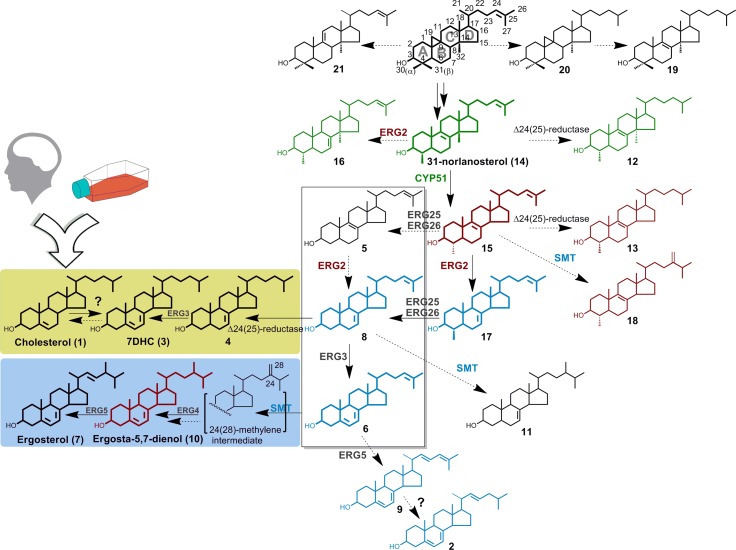
Sterol metabolic network in N. fowleri.The pathway is reconstituted based on the metabolites observed in the untreated N. fowleri (shown in bold) and treated with the CYP51 (shown in green), SMT (in blue) and ERG2 (in dark red) inhibitors. Metabolites not observed in the wild-type N. fowleri are depicted in thin lines. The cholesterol arm of the pathway is highlighted by the yellow-green background, the ergosterol arm is highlighted by the blue background. Enclosed in frame are potential SMT substrates. Enzymes interrogated in these studies are labeled in colors corresponding to the accumulating metabolites. Numbering of atoms in sterol molecule is adapted from Nes and Venkatramesh, 1994.[41] Sterol labelling is as in Table 1. ERG enzyme nomenclature is according to the convention for S. cerevisiae.